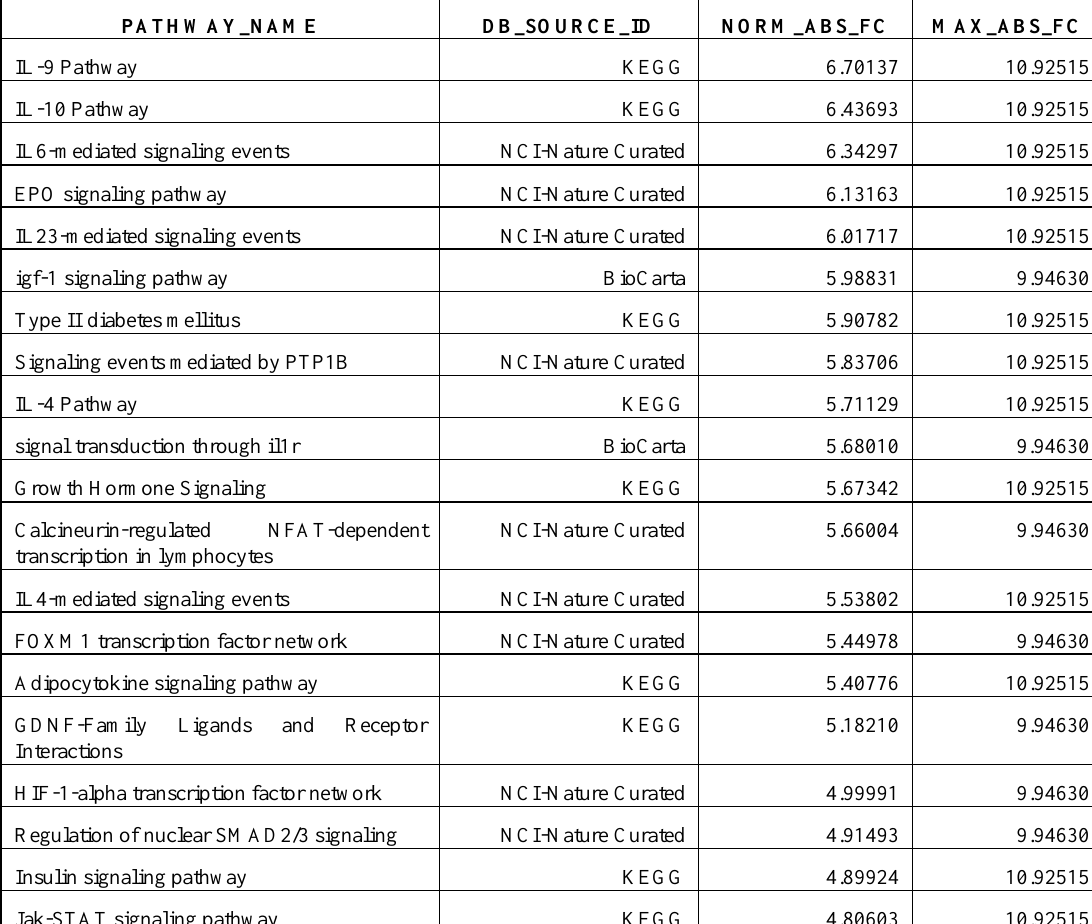
Table 6: Top-20 significant pathways in IAB from GSE24215, ordered by pathway differential expressions (p*-norm), which is measured with all the available differential gene expressions in IAB from